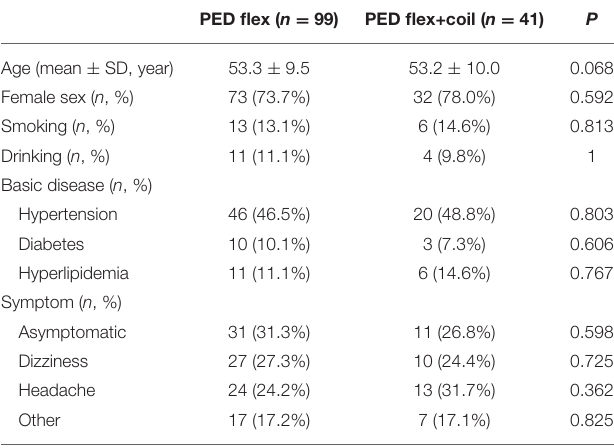
TABLE 1 | Demographic and clinical characteristics of patients. TABLE 2 | Aneurysm characteristics.